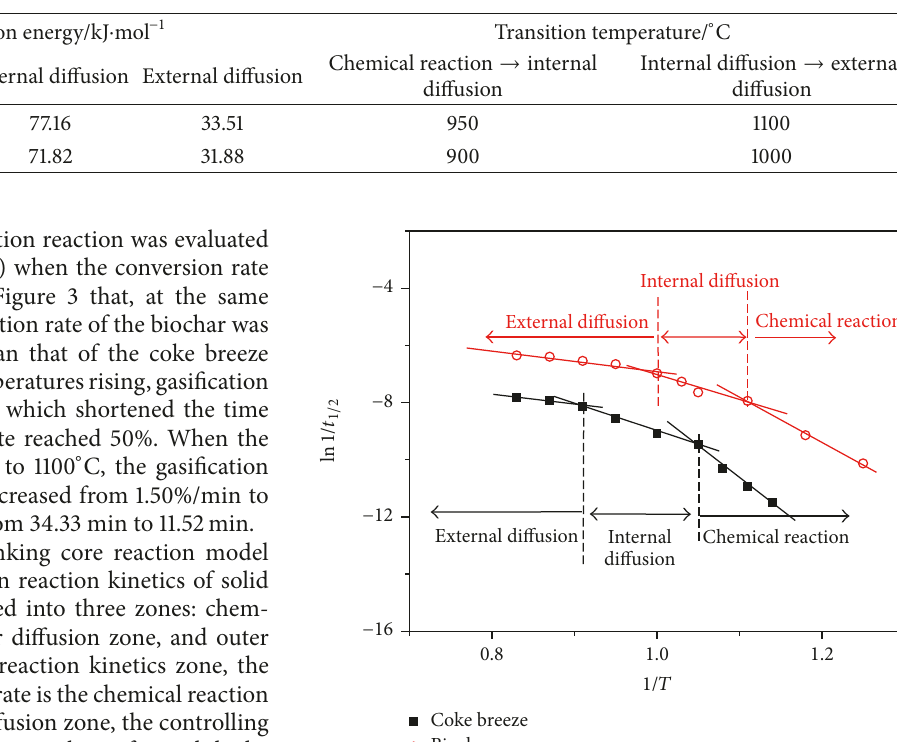
Table 3: Activation energy of fuel gasification and the transition temperature of every zone.